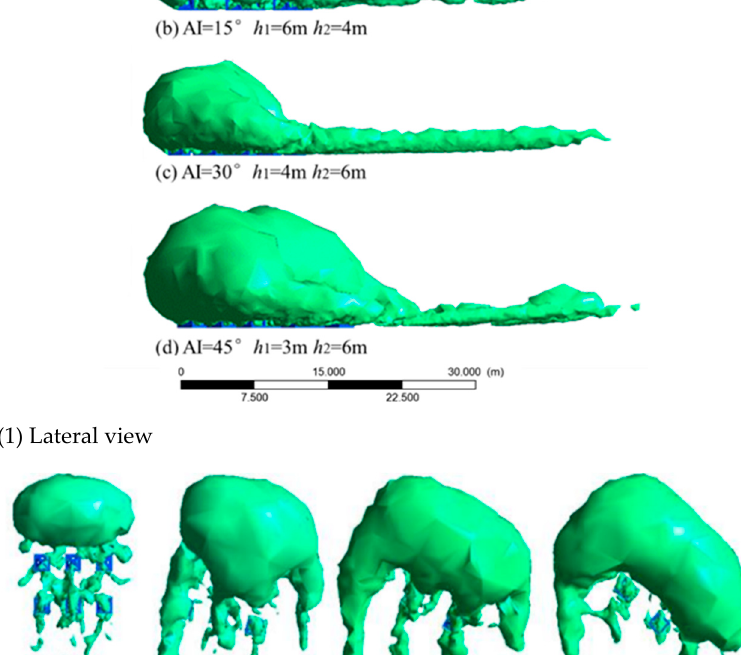
Figure 16. Wake volume of the optimal layout with the AI of 0°, 15°, 30°, and 45° (m 3 ) . 3.5. Influence of Inflow Velocity on the Flow Field As stated above, the UR with h 1 of 1 L, h 2 of 2 L, and the AI of 45° has the best flow field effect. The efficiency indices were used to evaluate the influence of inflow velocity on the flow field effect of the optimized UR. As shown in Figure 17, these indices of the optimized UR fluctuate slightly under the condition of inflow velocity variation, which indicates that the flow field of UR is little affected by the variation of inflow velocity. This is similar to the result of individual AR [25,36,37].